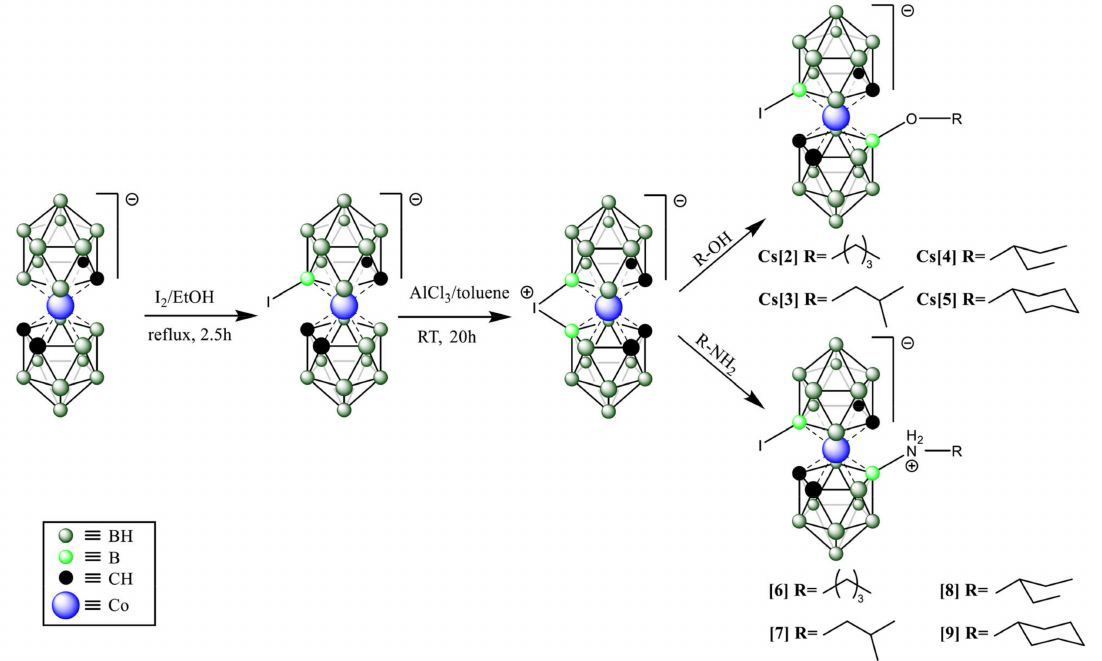
Scheme 1. The synthetic scheme used to generate the top compounds from the screening strategy. Detailed synthetic procedures and analysis of compounds are provided under the Materials and Methods